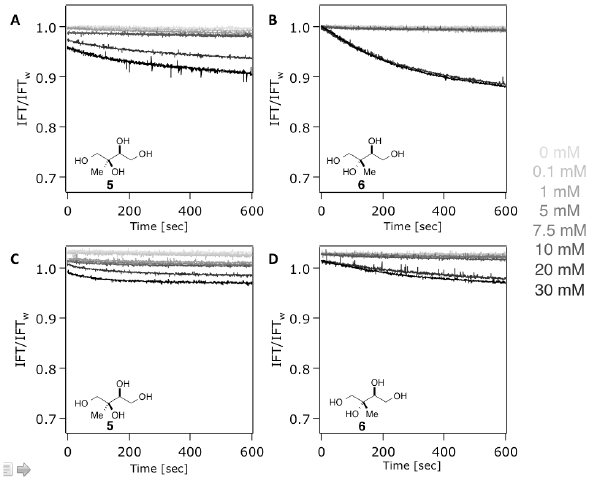
357 Figure 4 . Dynamic surface tension measurements for 2-methyltetraol compounds in 358 dH 2 O (A and B) and 1 M (NH 4 ) 2 SO 4 (C and D). A/C) syn-2-methyltetraol (5) B/D) anti-359 Figure 4. Dynamic surface tension measurements for 2- methyltetraol compounds in d H 2 O (a, b) and 1M (NH 4 ) 2 SO 4 (c, d) . (a, c) syn-2-methyltetraol (5) and (b, d) anti-2-methyltetraol